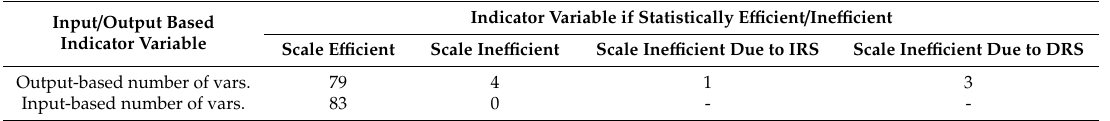
Table 5. Status of scale e ffi ciency. DRS, decreasing returns to